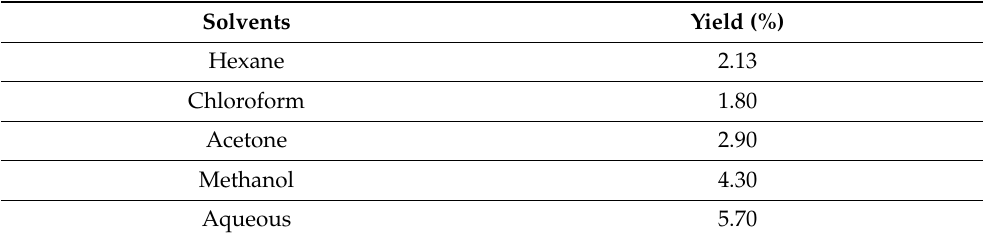
Table 1. Yield percentage of S. heteromalla in different solvents.